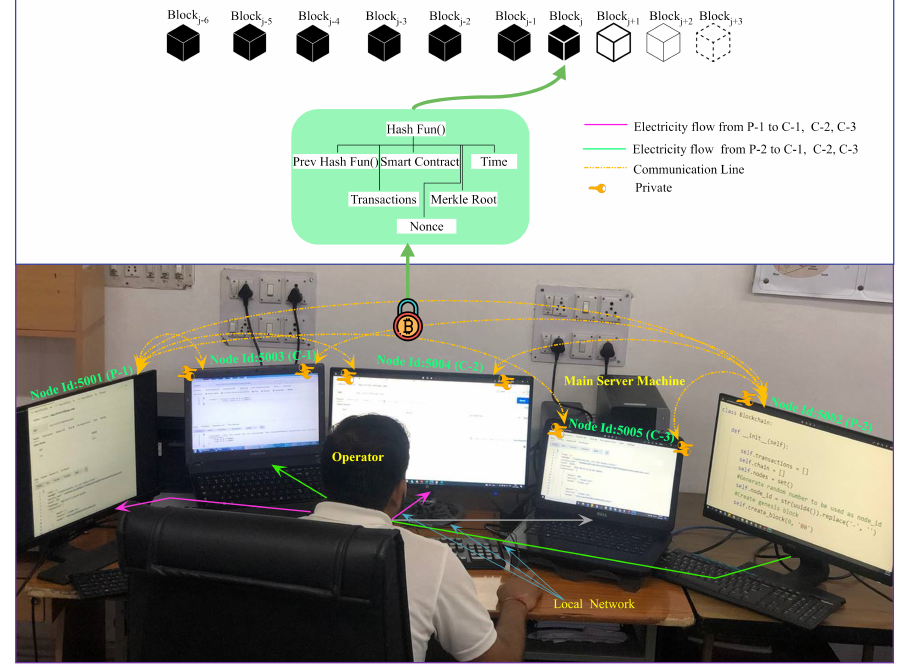
Figure 5. Blockchain for the trading process. Energy Trading